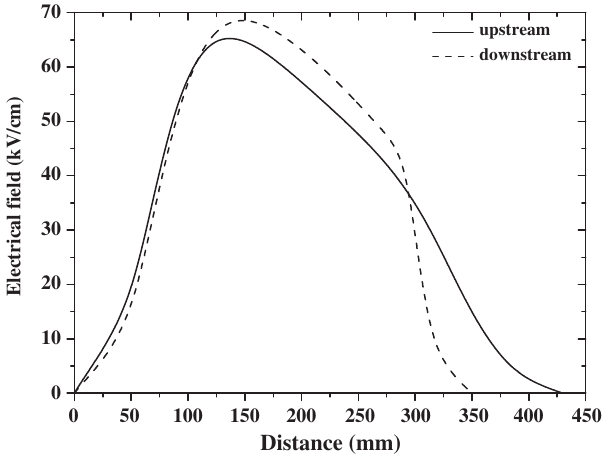
FIG. 6. Electrical fields distribution on the diaphragms-water interfaces of the ISC. The solid line indicates the stresses at the upstream end, while the dashed line denotes the fields at the downstream side. The peak fields on the upstream and down- stream plastic barriers are 65.2 and 68 . 7 kV = cm, respectively. Those values are lower than the maximum stress on the ISC barriers of the RITS accelerator [4]. FIG. 7. Block diagram of the control system of the seven